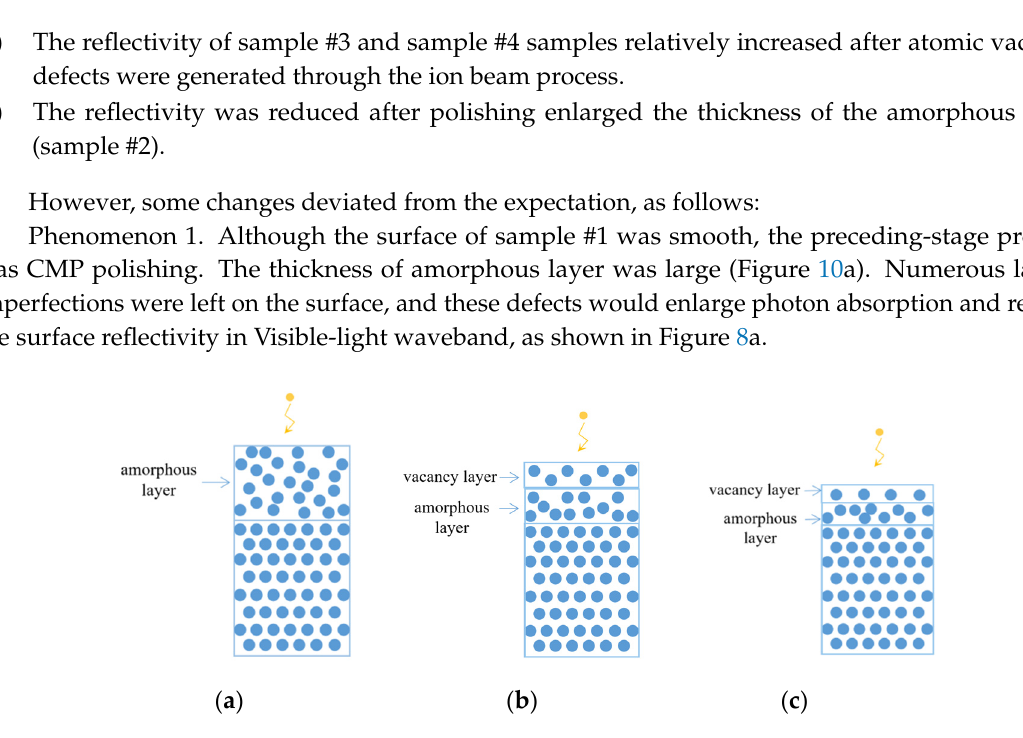
Figure 10. Lattice defect structures on surface of the ( a ) #1, ( b ) #3 and ( c ) #4 samples.